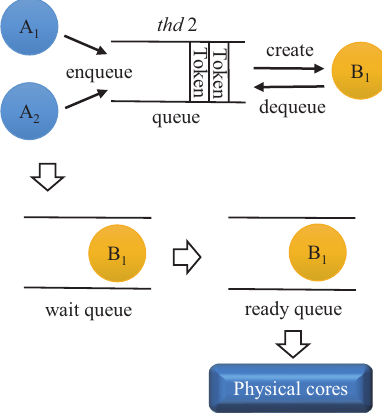
Figure 5. SDAG model